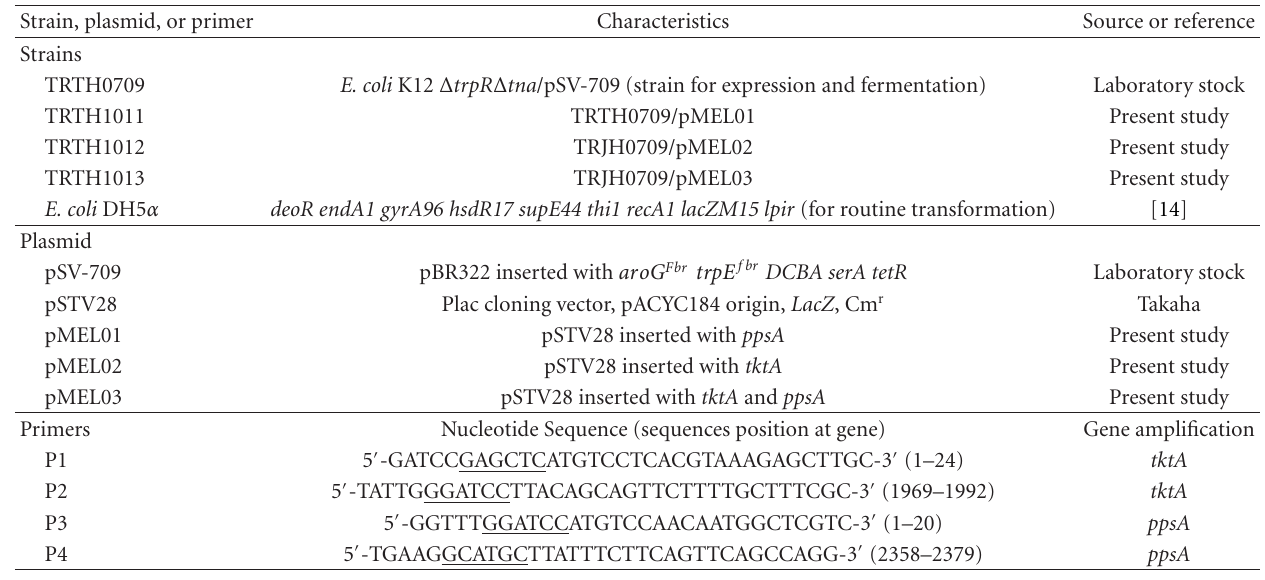
Table 1: Plasmids, strains, and primers used in the